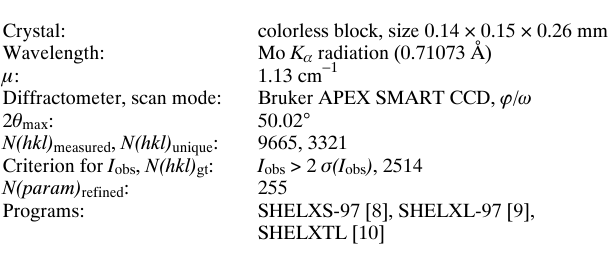
Table 1. D a t a collection a nd h a